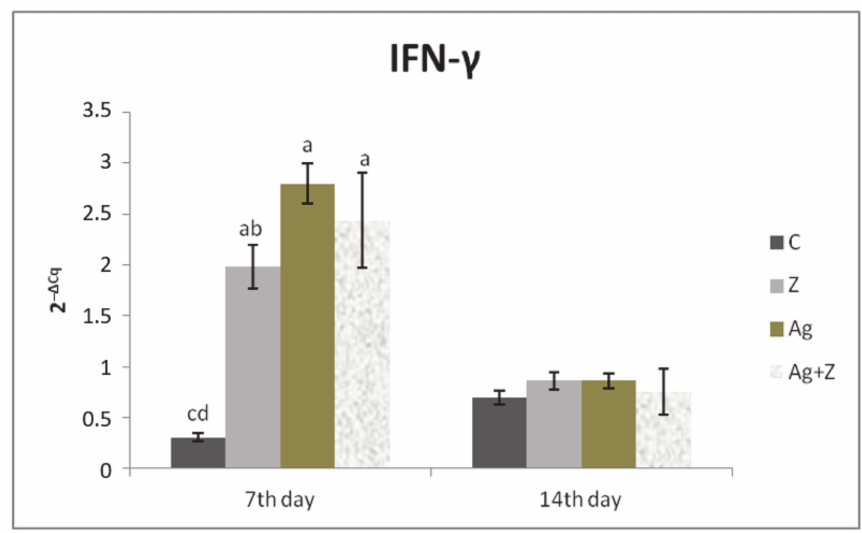
Figure 3. Relative expression of IFN- γ gene in the jejunum of chickens treated with inorganic ZnSO 4 and infected by A. galli . Results at each time point are the median of 2 − ∆ Cq . Means with different superscripts are significantly different. ab p <0.05; ad p < 0.001.